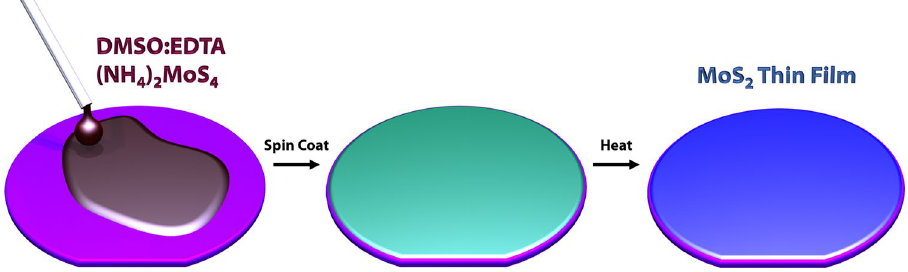
Figure 1. Schematic of spin coating process. Solution application onto the wafer is illustrated along with color observation of after spin coating and heating process.